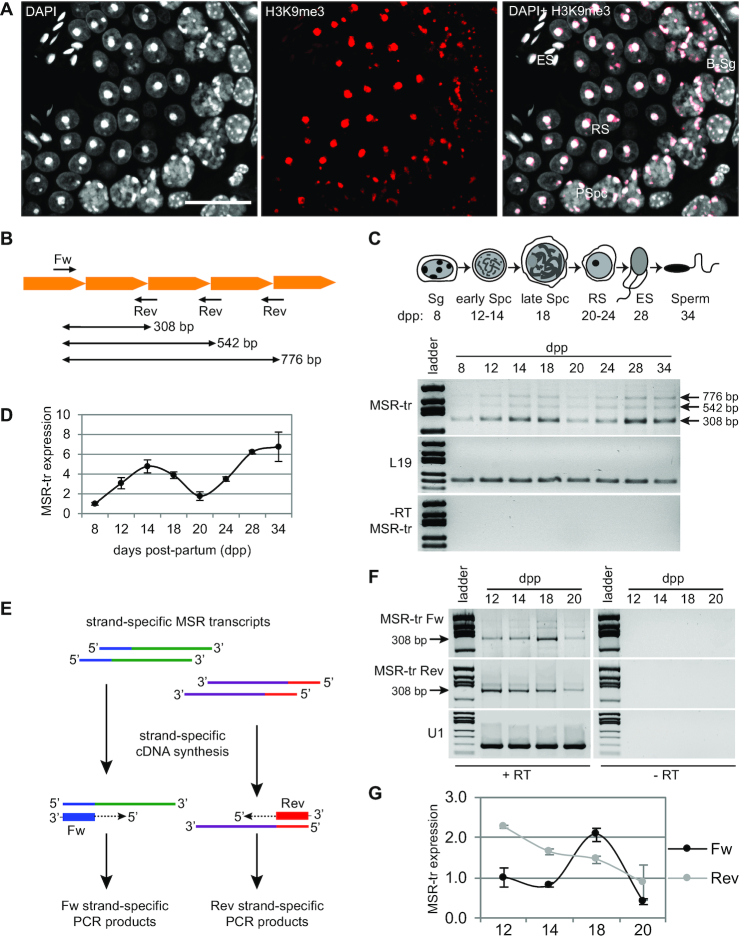
Major satellite repeats are transcribed during spermatogenesis. (A) Immunofluorescence on adult PFA-fixed paraffin-embedded testis sections (stage VI) using an antibody against H3K9me3 visualizes the accumulation of H3K9me3 signal at chromocenters of spermatogonia, spermatocytes and round spermatids. B-Sg, type B spermatogonium; PSpc, pachytene spermatocyte; RS, round spermatid; ES, elongating spermatid. Scale bar: 25 μm. (B) Schematic diagram showing the location of forward (Fw) and reverse (Rev) primers for the amplification of major satellite repeat (MSR) transcripts. Each pointed orange block corresponds to a consensus MSR sequence. See also Supplementary Figure S1A. (C) MSR transcripts (MSR-tr) are expressed during the first wave of spermatogenesis. Testis samples were collected from juvenile WT mice at different time points and MSR-tr expression was analyzed by semi-quantitative RT-PCR. L19 was used as a reference gene. The reactions without a reverse transcriptase enzyme (-RT) control genomic DNA contamination. (D) The intensities of MSR-tr 308 bp bands as in (c) from two independent experiments were quantified using ImageJ and normalized to the intensity of L19 band in the same sample. MSR-tr expression is shown relative to 8 days post-partum (dpp) sample that was set as ‘1’; n = 2, error bars represent standard errors of the mean (SEM). (E) Schematic diagram of strand-specific RT-PCR using either Fw or Rev primers in the reverse transcription reaction to specifically amplify only forward or reverse strand. (F) Expression of MSR forward (Fw) and reverse (Rev) strands in testis samples collected at different time points during the first wave of spermatogenesis. U1 small nuclear RNA was used as a reference gene. (G) The intensities of MSR-tr 308 bp bands from two independent experiments were quantified using ImageJ and normalized to U1 expression in the same sample. Expression is shown relative to MSR Fw 12 dpp sample that was set as ‘1’; n = 2, SEM.